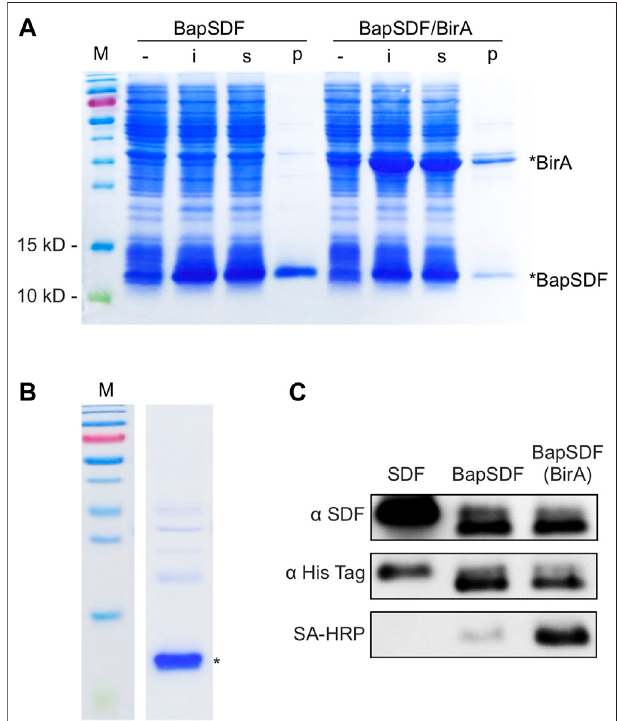
FIGURE 1 | Expression and puri fi cation of BapSDF. (A) BapSDF and BapSDFco-expressedwithBirAstrainswereinducedbyIPTG.Then,thecells were lysed, and different components were collected for detection. -, whole- cell extraction before induction; i, whole-cell extraction after IPTG induction; s, supernatant ofthe i th sample; p, precipitate of the i th sample. (B) Puri fi ed BapSDF co-expressed with BirA. (C) Western blotting was used to detect the levels of SDF, BapSDF, and BapSDF co-expressed with BirA using the SDF antibody, His-tag antibody, and HRP-conjugated Sa. BapSDF was puri fi ed, and biotinylated BapSDF was veri fi ed using HRP-conjugated